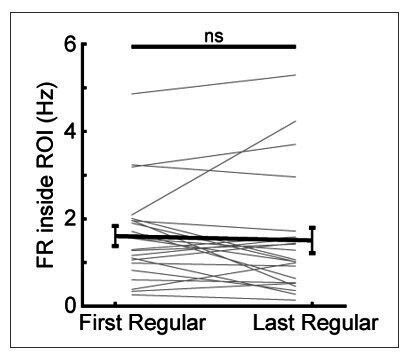
Firing rate of border cells inside the object ROI between the first and last regular session without an object present.Individual cells (grey lines) show both increased and decreased firing, but no mean difference was found between the sessions, as expected (First regular, FR = 1.61 ± 0.23; Last Regular, FR = 1.50 ± 0.29; Wilcoxon signed rank test: z = -0.763, p = 0.45).